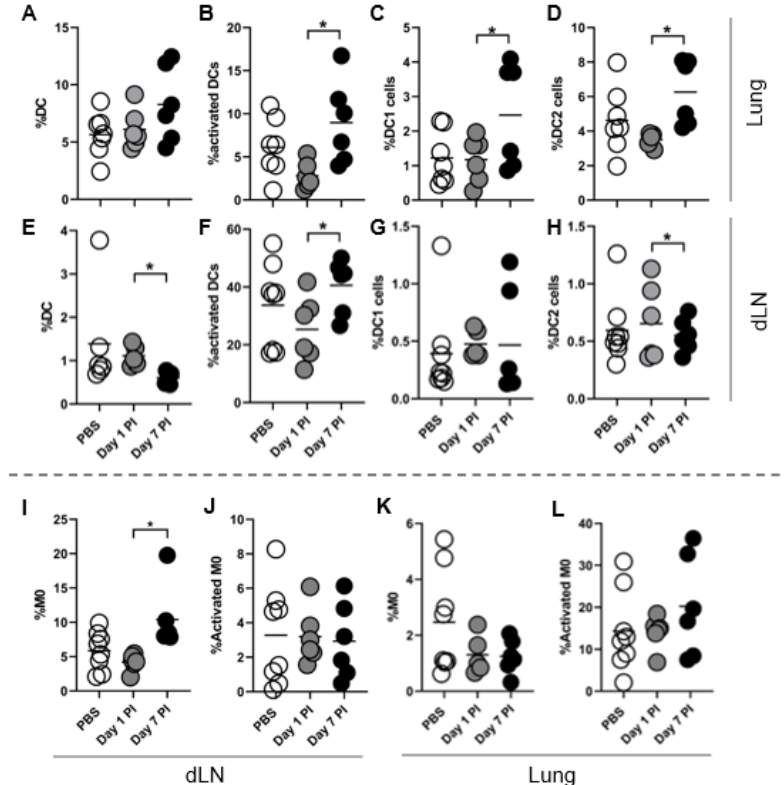
Figure 5. DC1 and DC2 increase in frequency at day 7 post-infection. C57BL/6 mice were intranasally infected with 10 5 arthroconidia or PBS. Cell frequencies are comparable to uninfected mice (data not shown). Both lung lobes were collected and homogenized for flow cytometry analysis. Draining lymph node (dLN) refers to the pulmonary lung-draining LN. DC1 ( C , G ) and DC2 ( D , H ) populations are gated from CD11c+ population ( A , E ). DC1 are defined as CD8a+SIRPa-CD11c+ and DC2 as CD8a-SIRPa+CD11c+. ( B , F ) Activated DC frequency accounts for all DCs including DC/DC1/DC2. ( I , K ) Macrophages are defined as F4/80+ cells and ( J , L ) activated population is gated from the F4/80+ population. Activated cells are defined as CD86+MHC-II+ cells. n = 6–8 individual mice from 3 experiments. For all plots displayed line indicates mean and each dot is one experimental replicate. Comparisons were made between mock PBS infection and infected at each time point. Data was analyzed using unpaired Student’s t -test and outliers excluded using Grubbs Outlier exclusion analysis; * p < 0.05.